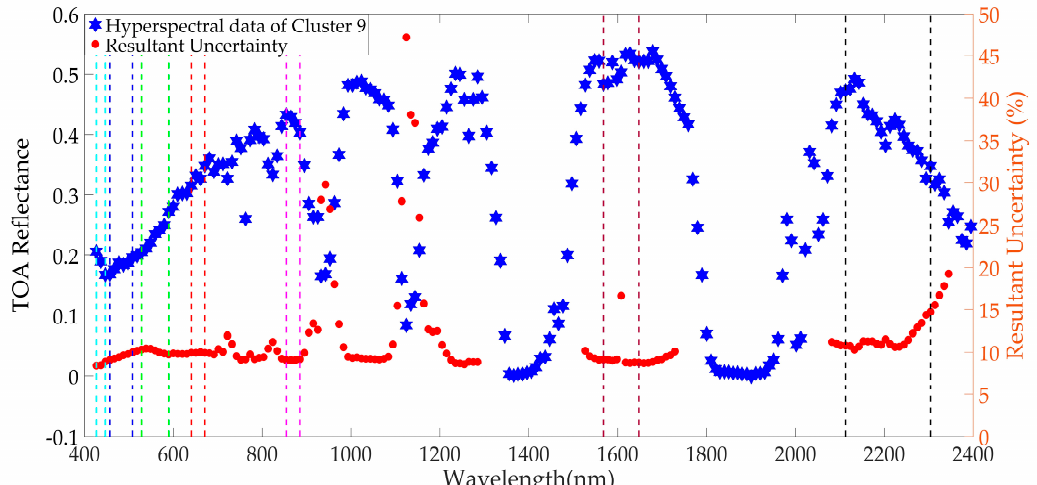
Figure A6. Estimated representative hyperspectral profile of Cluster 8 and its resultant uncertainty.